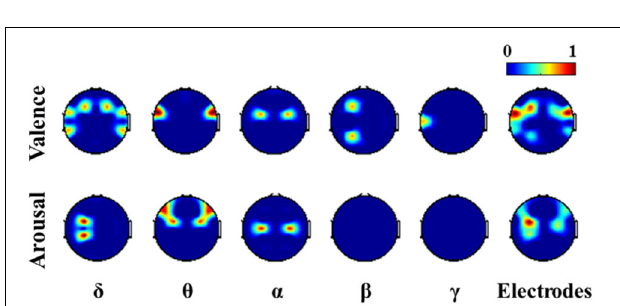
the nodes represent the mean values of the results. † Indicates that the accuracy with feature selection significantly outperformed that without feature selection ( p < 0 . 01), yet were comparable ( p > 0 . 1) to majority voting accuracies (valence: ∼ 63%, arousal: ∼ 61%).